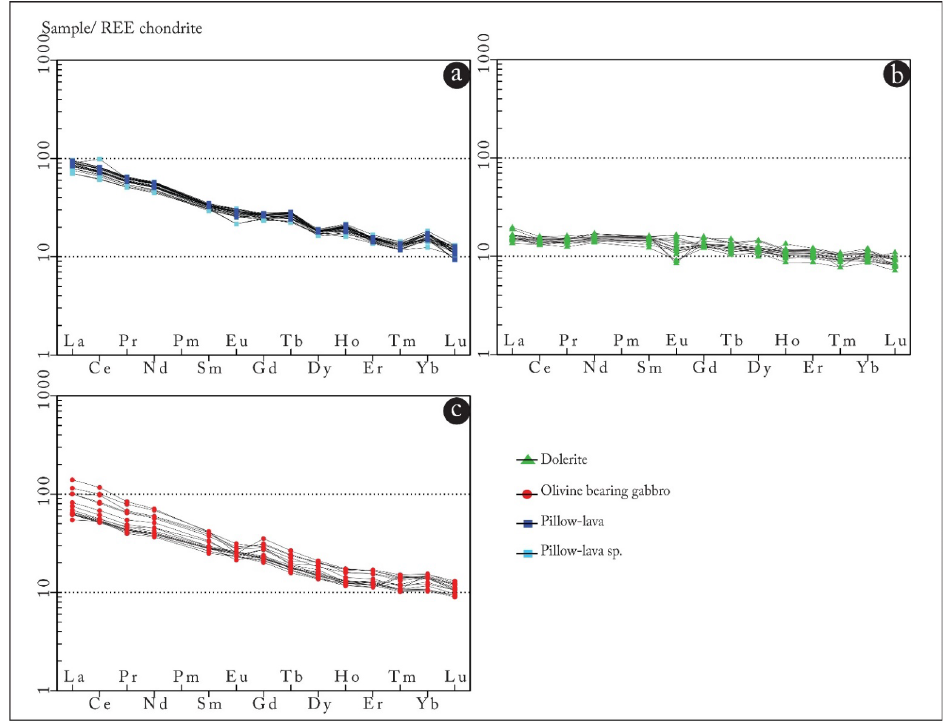
Figure 23. Spectra of rare earths normalized to chondrites [65] for magmatic rocks ofNNEAchemmach. ( a ): Pillow-lavas, ( b ): dolerites, ( c ): Olivine-bearing gabbros.